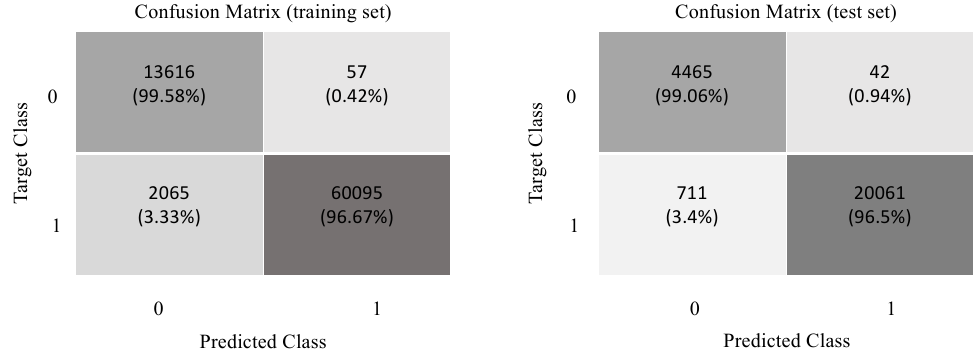
Figure 11. Confusion matrix for the 1DCNN model.